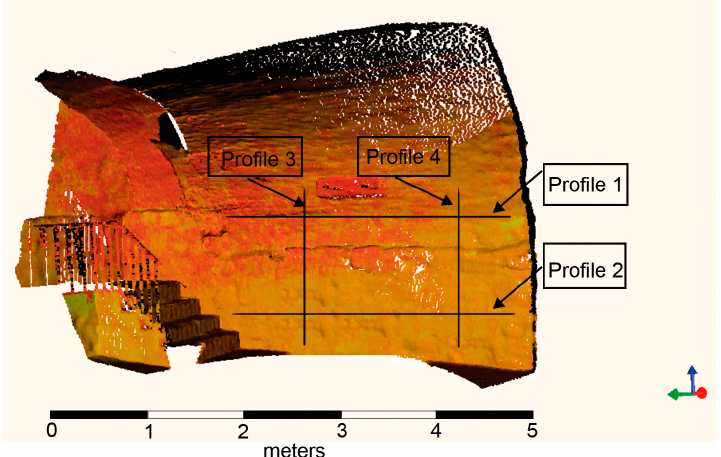
Figure 7. 3D laser model with the GPR profiles